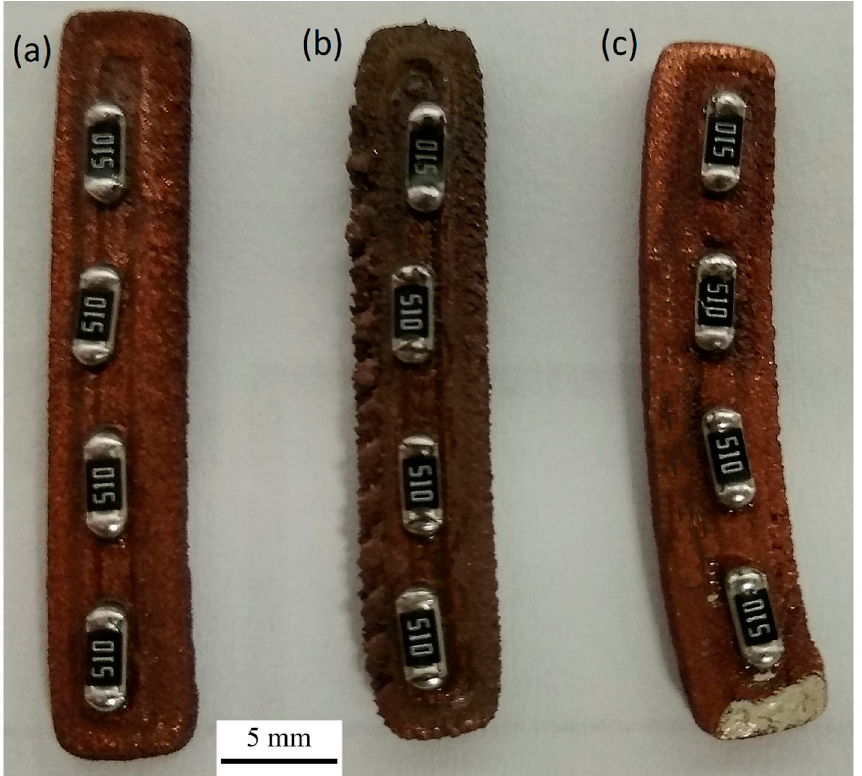
Figure 6. Soldered joint fabricated with reflow soldering on different composites: ( a ) ABS/Cu, ( b ) PLA/Cu, ( c ) PS/Cu.